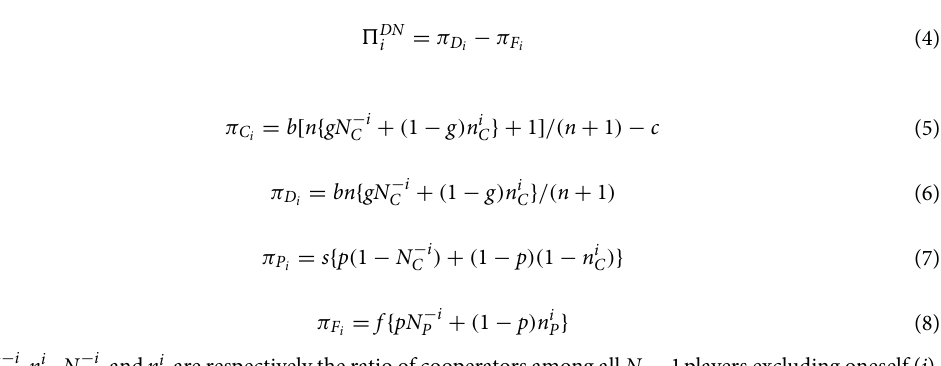
Figure 1. Average cooperation rates in 100 trails after 100 generations. From the left, each panel is a case of p = 0, 0.25, 0.5, 0.75, 1 , respectively. In each panel, the horizontal and vertical axes represent the values of a and g , respectively. The panel is a heat map, and the values shown are the average cooperation rates. Parameters are ( N , n ) = ( 100, 4 ) , ( b , c , f , s ) = ( 2, 1, 6, 3 ) , and µ = 1% . This image is made by using Python 3.7.2 (www. python.